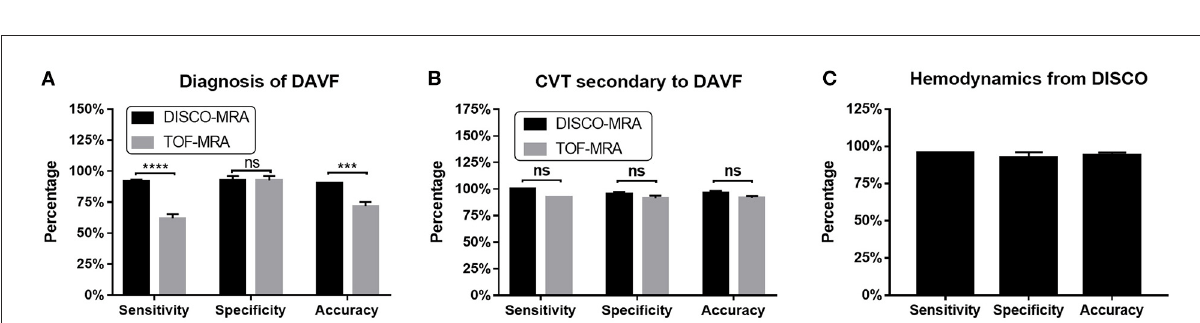
FIGURE3 For DAVF detection, the sensitivity of DISCO-MRA ( P < 0.0001) and accuracy ( P = 0.0007) were significantly higher than TOF-MRA (A) . No significant difference in specificity between DISCO-MRA and TOF-MRA ( P = 0.1368). With regard to CVT detection, no significant difference in sensitivity, specificity and accuracy between DISCO-MRA and TOF-MRA (all P > 0.05) was found (B) . For hemodynamics detection, DISCO-MRA had a sensitivity of 95.45% (95% CI: 78.2–99.77%), a specificity of 95.0% (95% CI: 76.39–99.74%) and an accuracy of 95.24% (C) . *** P ≤ 0.001; **** P ≤ 0.0001; ns, P >